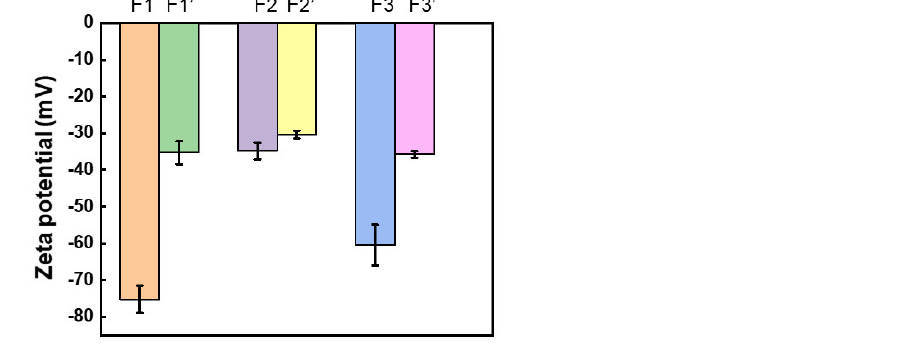
Figure 5. Histograms for zeta potentials of the prepared emulsions: F1, F1′, F2, F2′, F3, and F3′.